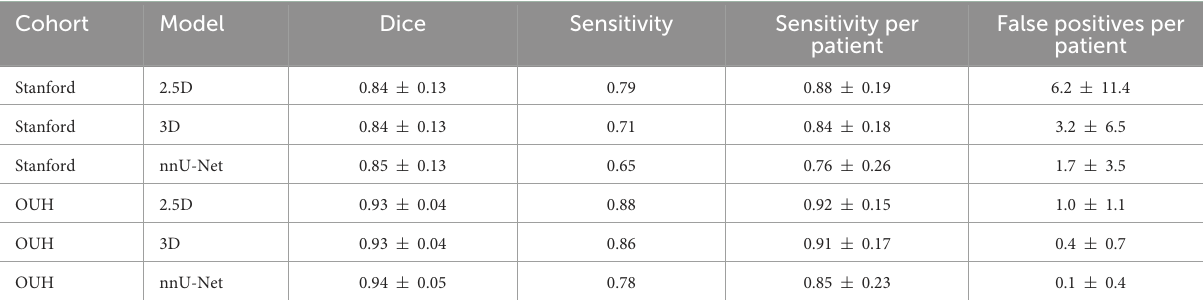
TABLE 4 The dice similarity coefficient, metastases detection sensitivity, the average metastases detection sensitivity per patient, and the average number of false positive metastases per patient with the corresponding standard deviation for the Stanford and OUH cohorts.